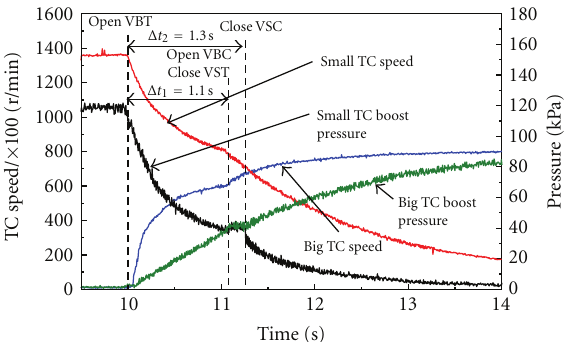
Figure 7: Process from the big TC to the small TC at Δ t 3 = 0 . 9 s and Δ t 4 =